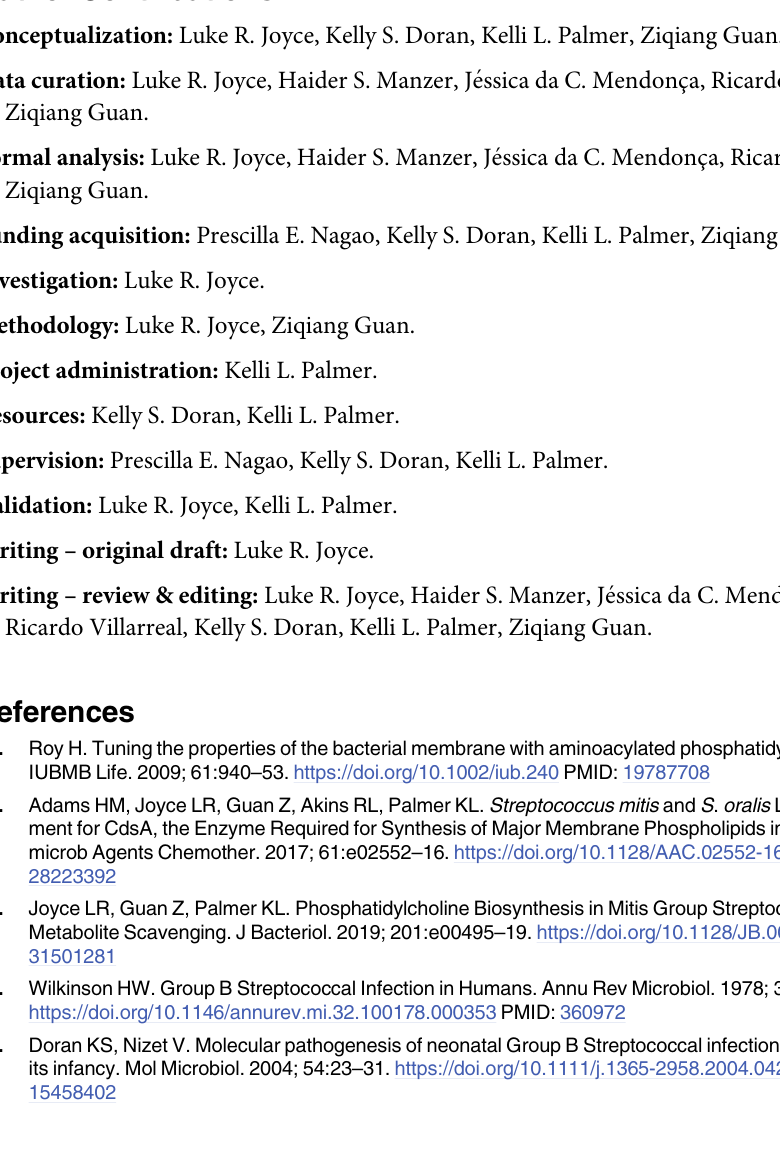
S2 Table. Strains and plasmids used in this study. S3 Table. Primers used in this study. S1 Data. Numerical data points underlying presented